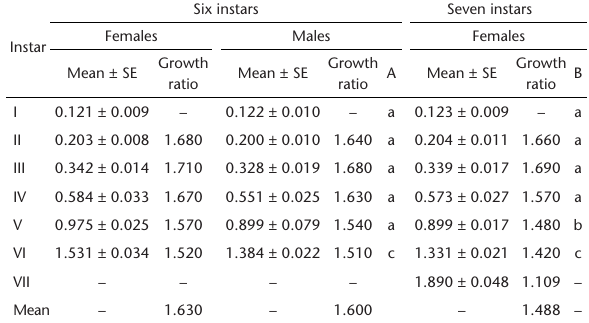
Table 3. Distance between frontal setae (mm) of Spodoptera cosmi- oides larvae at each instar and respective growth ratios, including larvae which developed through six (15 females and 15 males) and seven instars (13 females), fed with an artificial diet, under controlled conditions (25 ± 1°C, 70 ± 10% RH and 14 hour photophase). A. Student t-test considering variances between means of females and males with six instars; B. Same but between females with six and seven